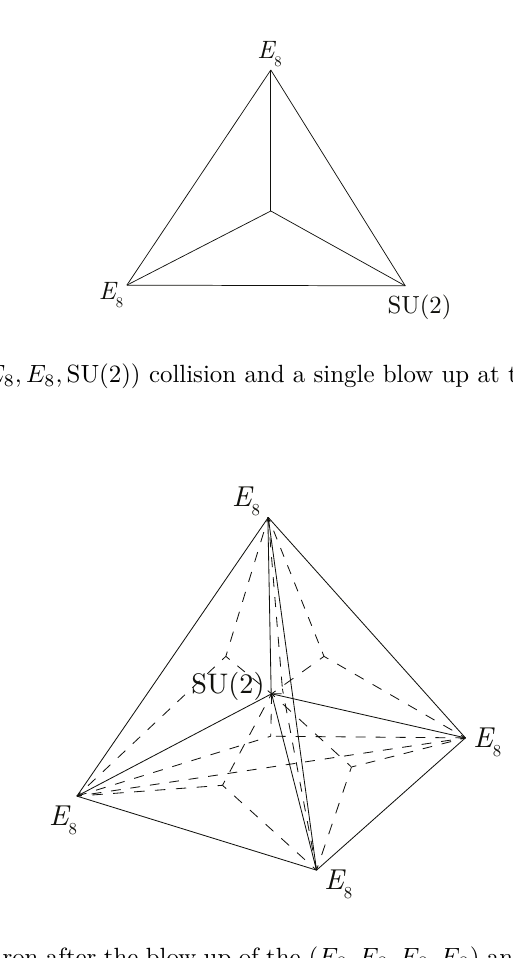
Figure 4 . The tetrahedron after the blow up of the ( E 8 , E 8 , E 8 , E 8 ) and ( E 8 , E 8 , SU(2))